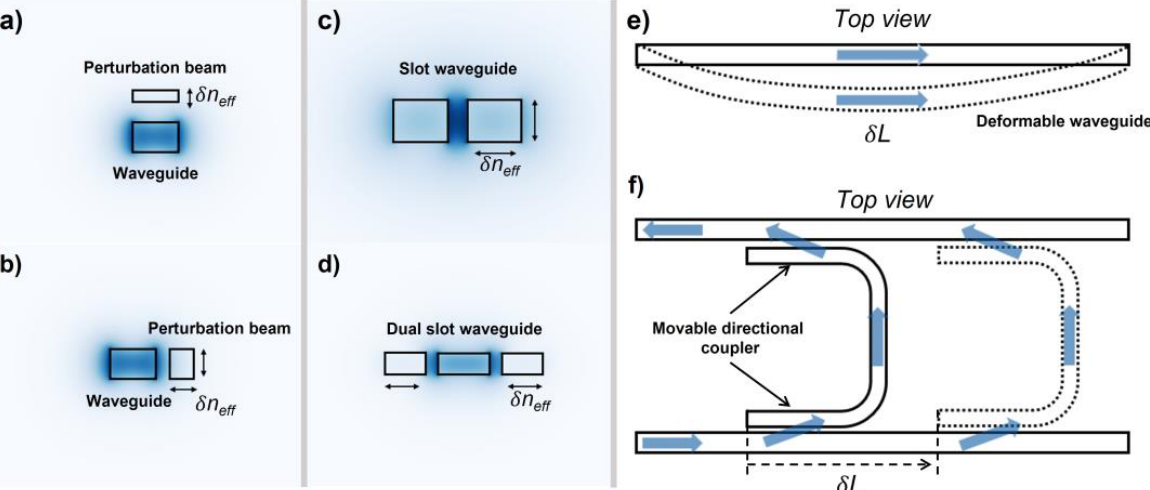
Figure 2. MEMS phase shifters based on evanescent field perturbation by ( a ) a silicon beam above the bus waveguide, ( b ) a cutoff width silicon beam is next to the bust waveguide; confined optical mode modulation through ( c ) slot waveguide, ( d ) dual slot waveguide; and modulating optical path length through ( e ) deformable waveguide, ( f ) horizontal directional coupler.